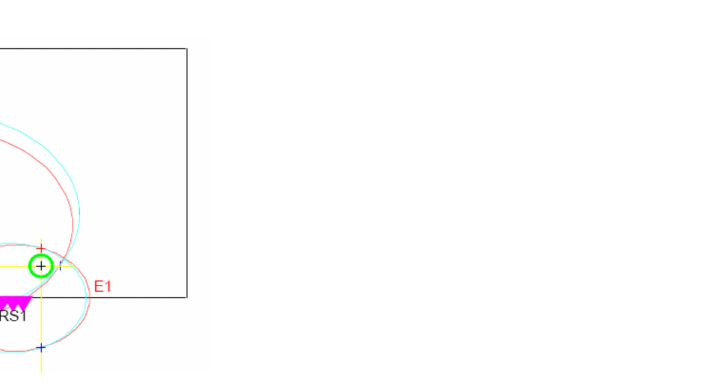
Figure 6. The intersection of the lines joining the intersections of the ellipse RS1 and RS2 sets in the point τ = 150.